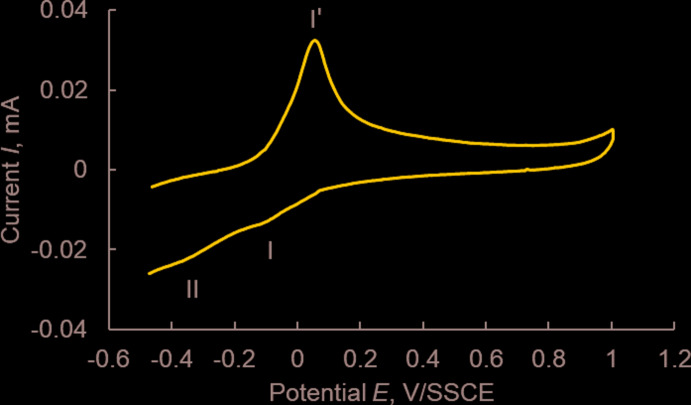
Cyclic voltammogram of [CuLCl2]2 (I), 0.1 mM in methanol mixed with 0.1 M acetate buffer (pH 4) and NaClO4 (70:28:2) as supporting electrolyte at a glassy carbon electrode and Ag/AgCl as reference electrode (scan rate: 100 mV s−1; T = 298 K).